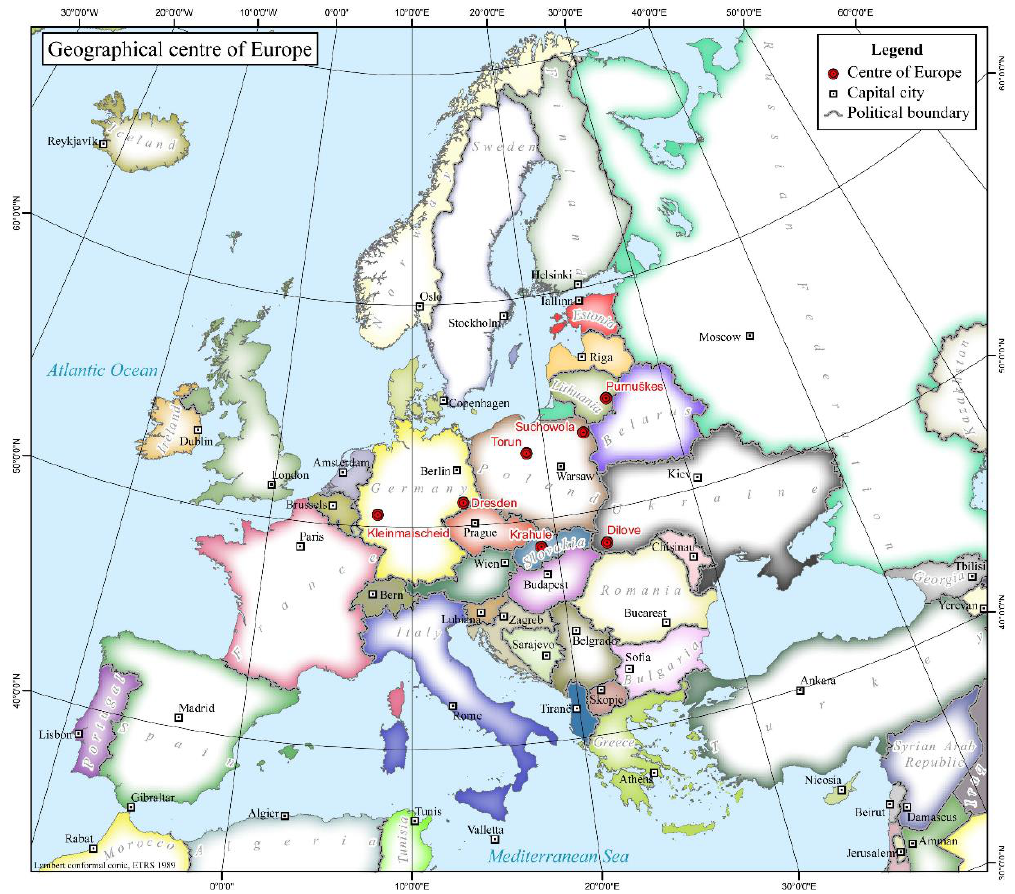
Figure 4. On the map [16], the red dots indicate some of the places where claimants for the title of the center of Europe are located: Dilove (Rakhiv, Ukraine), Krahule (or Kremnické Bane, Slovakia), Dresden and Kleinmaischeid (Germany), Torun and Suchowola (Poland), Bernotai or Purnuskes (Lithuania). Schematic representation by the authors of the article of the considered Central European area is highlighted by a blue ellipse. Reprinted with permission from [16]. Copyright 2009 by the Creative Commons.